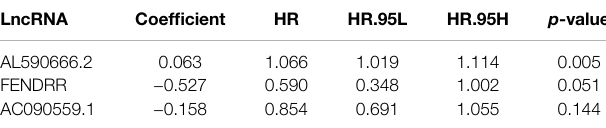
TABLE 2 | Multivariate Cox regression analysis of three prognostic lncRNAs. LncRNA